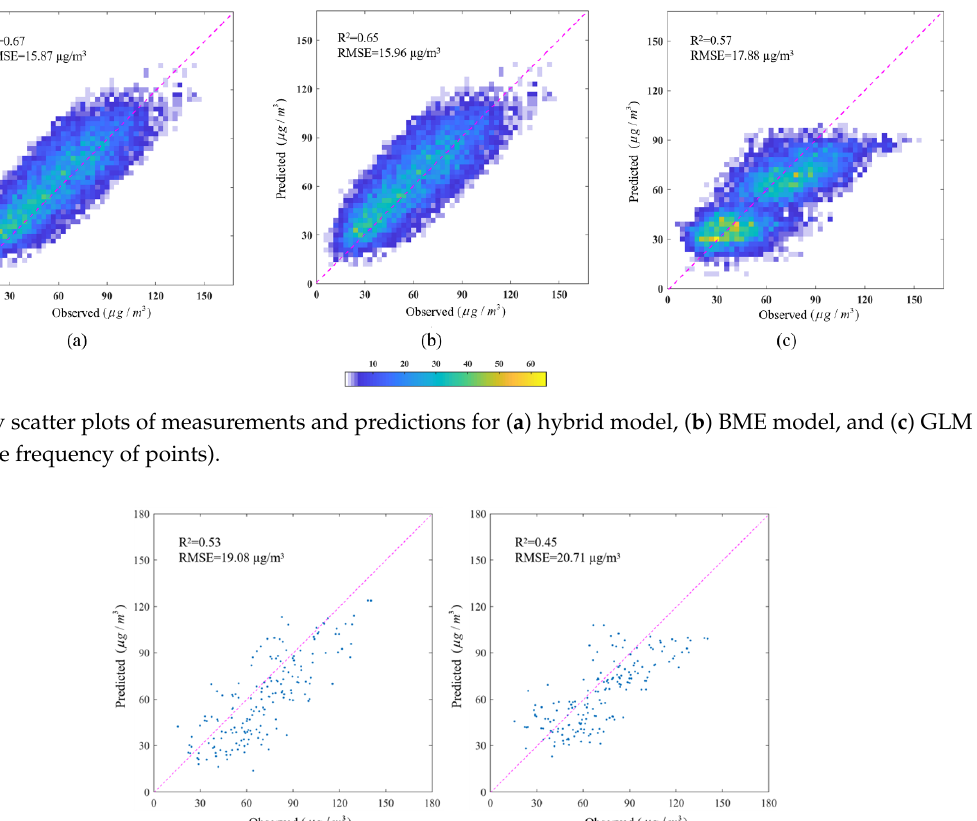
Figure 8. R 2 -based accuracy evaluation of the hybrid model for different seasons. As shown in Figure 9, the model performance exhibited spatial variations, with R 2 between 0.56 and 0.81. The best performance was achieved in East, Central, and North China, with R 2 values of 0.81, 0.80, and 0.77, respectively. A similar spatial pattern has also been reported in the literature [9,30,35]. The spatial variation could be affected by the sam- pling density and terrain condition. Dense monitoring stations improved the prediction accuracy of the hybrid model in East and Central China, while sparse monitoring stations reduced the prediction accuracy in Southwest China. It has been acknowledged that topo- graphic effects have impacts on air convection, winds, precipitation and aerosol compo- nents [9], which in turn affect the predictive performance of the hybrid model. The rela- tively flat terrain in North and Northeast China resulted in higher predictive accuracy than the hilly and plateau landforms in the western part of China. Given the higher spatial resolution (i.e., 1 km  × 1 km) and greater precision, the hybrid model is highly recom- mended for predicting GOCs at the national scale. Thus, we used the hybrid model to predict the 1 km monthly average GOCs across China.